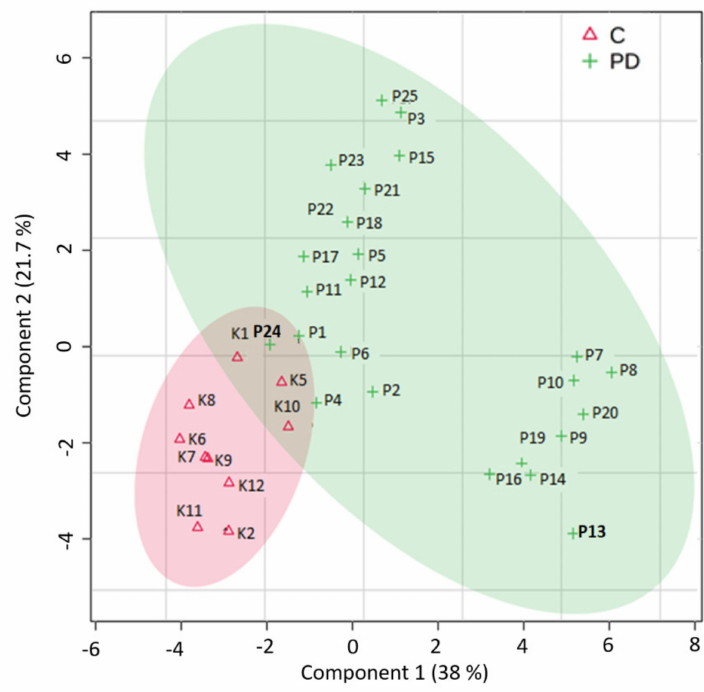
Figure 1. Partial least squares-discriminant analysis (PLS-DA) between normal controls and patients with Parkinson’s disease (PD). C—control group, PD—group of people with Parkinson’s disease.